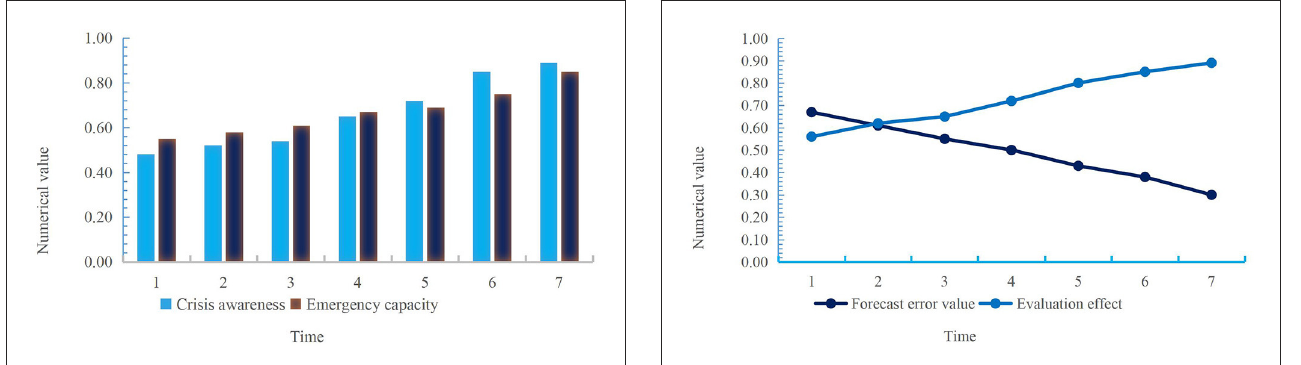
FIGURE6 Prediction error value and evaluation effect of civil servants’ comprehensive quality.